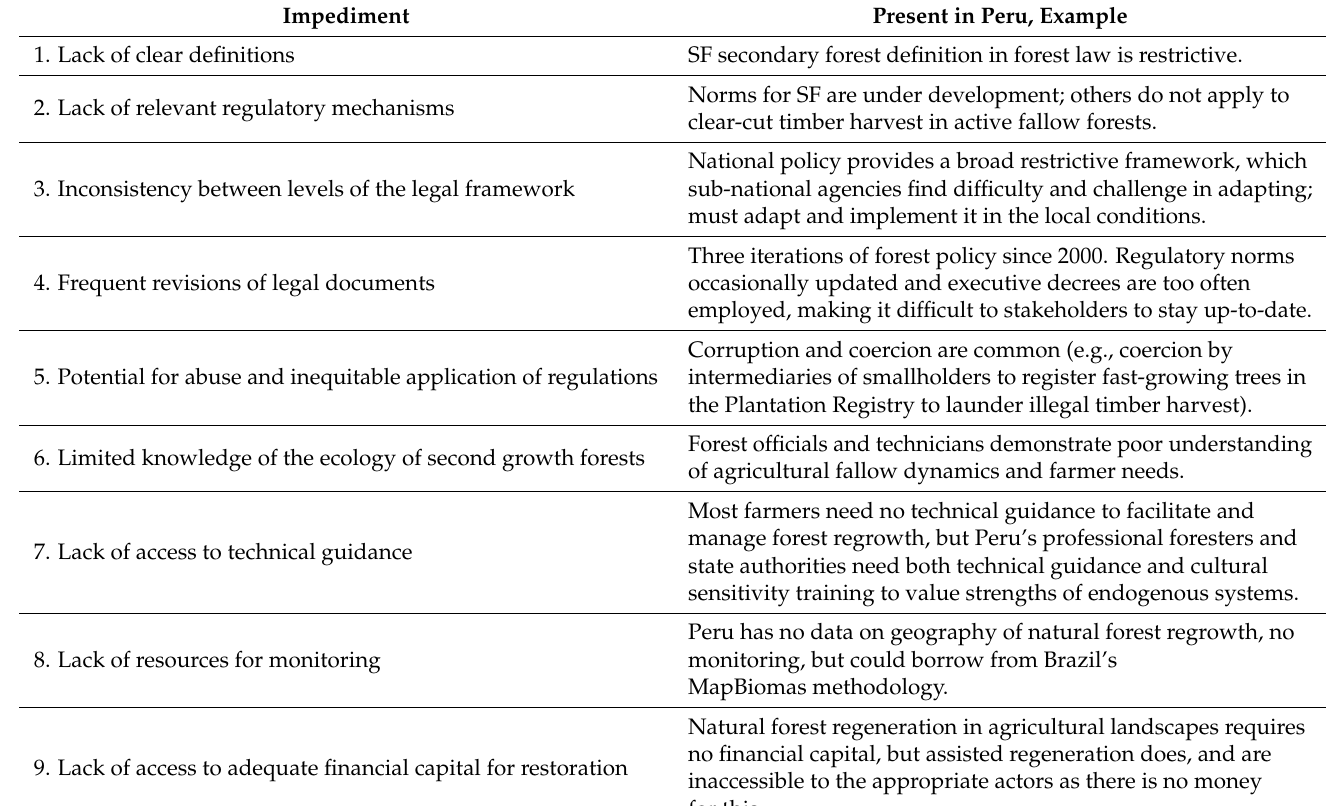
Table 1. Legal, behavioral, and operational impediments to secondary forest (SF) governance [19,25], with their applicability in